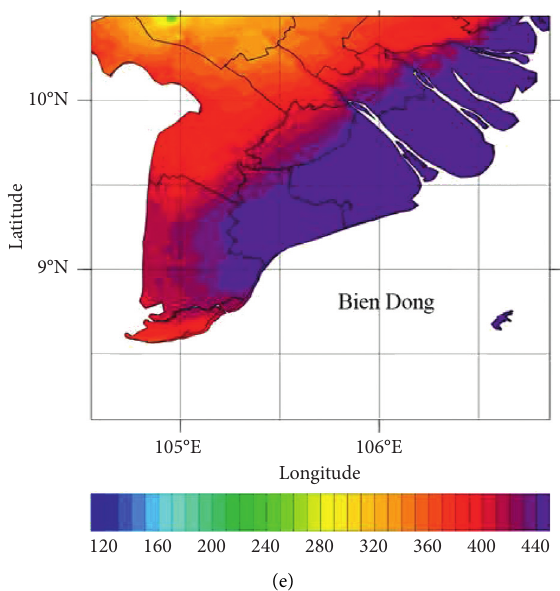
Figure 8: Simulated wind power density (WPD, W m − 2 ) computed from wind speed with bias correction at (a) 20m, (b) 50m, (c) 100m, and (d) 200m levels, and (e) 200m level but without wind speed bias correction.